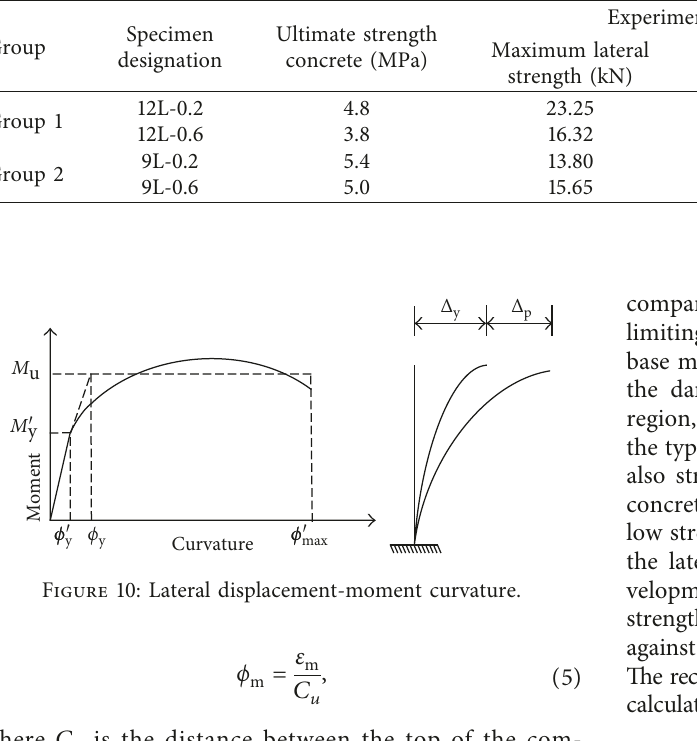
Table 4: Maximum lateral strength and ultimate drift ratio.